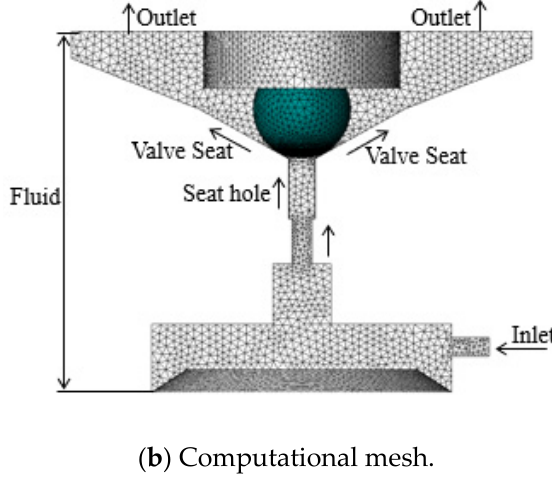
Figure 1. Model of control valve. Table 1. Structural parameters of the control valve.